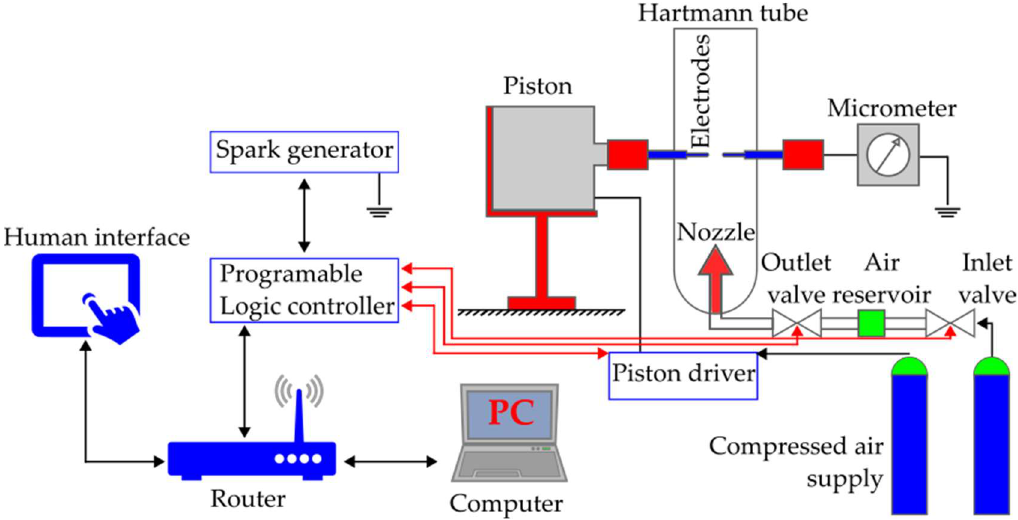
Figure 2. Measurement device for minimum ignition energy of Holi dust cloud.